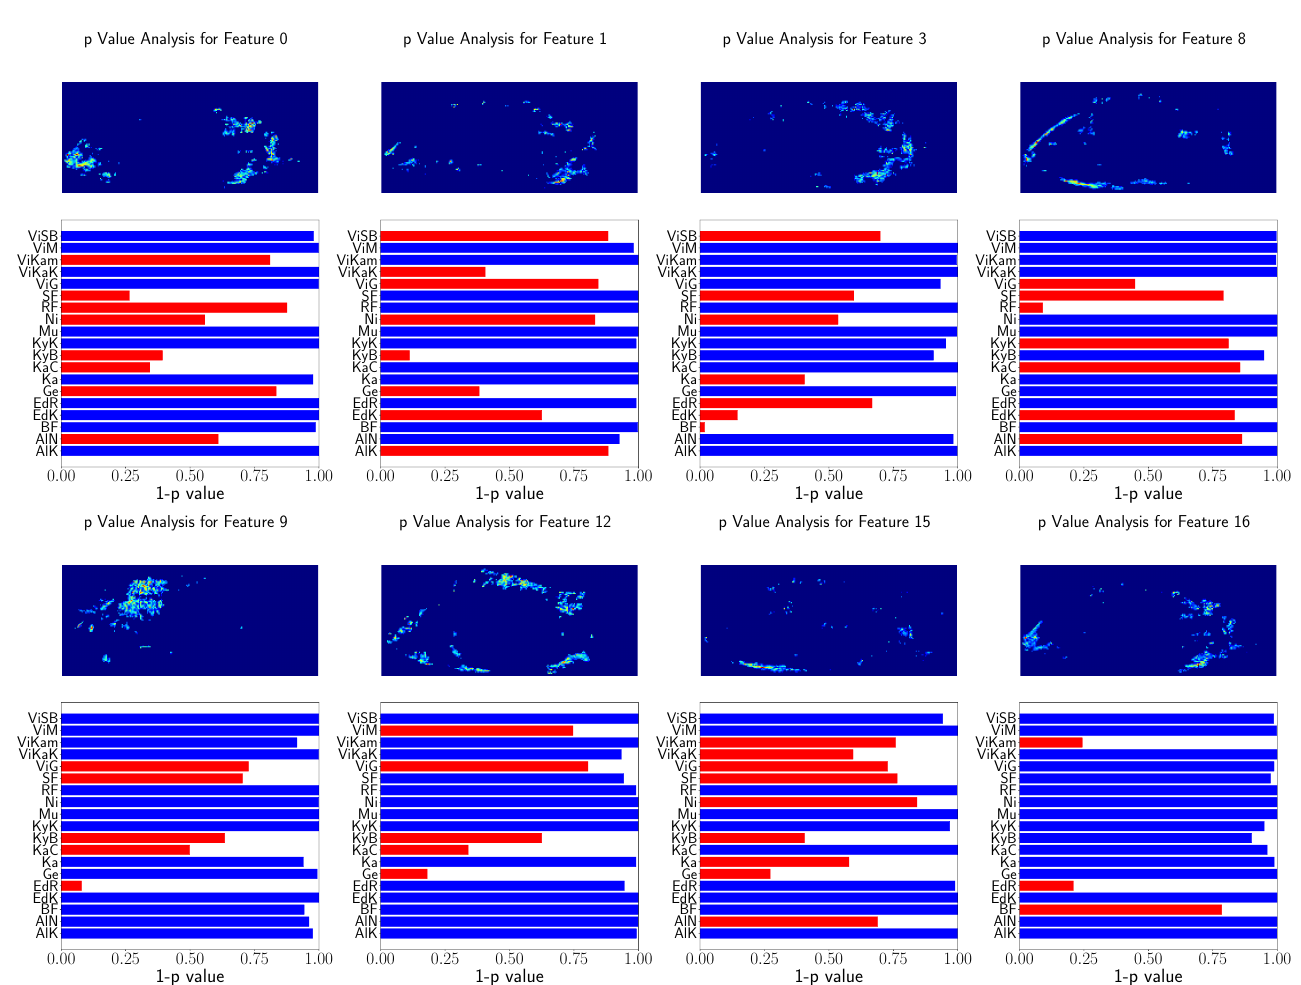
Figure 11. Results of Spearman’s rank correlation test for the relation between the manually selected AE features and population locations in Uganda. Randomly selected features are visualized. Features with a p -value above α = 0.1 are shown as red